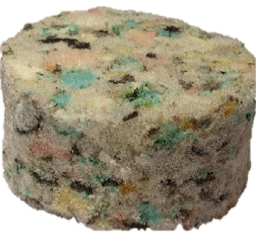
Figure 1. Recycled polyurethane foam used in this work.